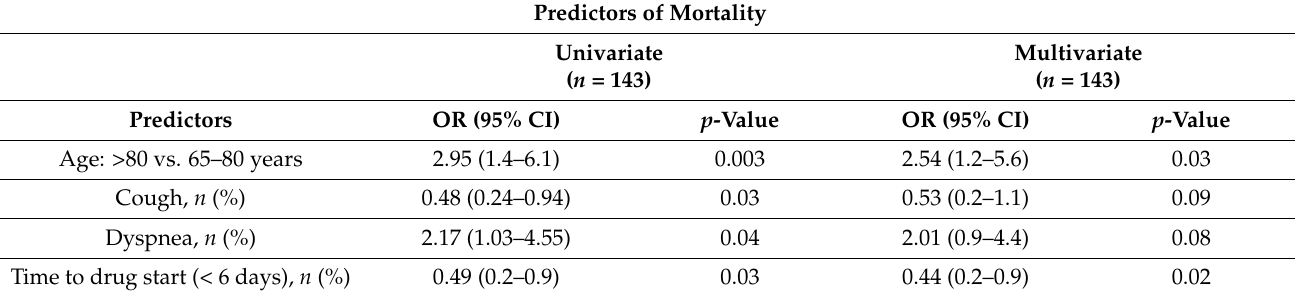
Table 2. Significant predictors of in-hospital mortality at univariate and multivariate analysis. ORs and 95% CI refers to the risk of mortality according to univariate and multivariate models.